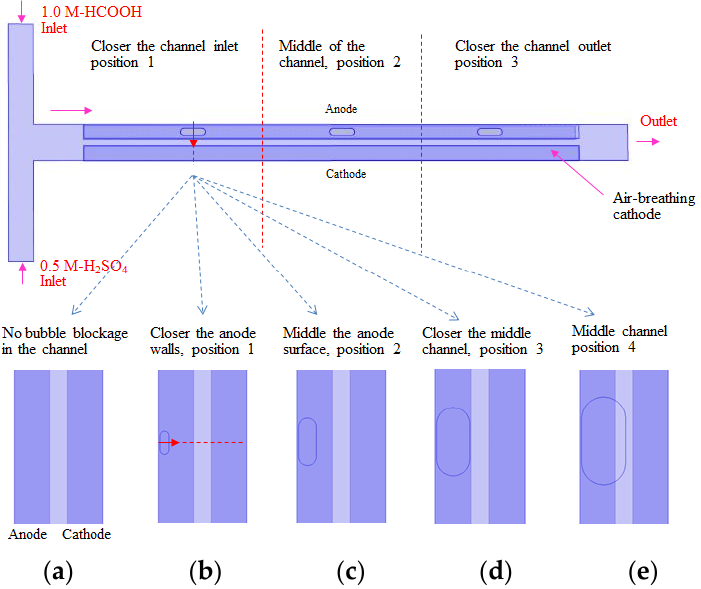
Figure 4. Distribution of bubble blockage starting from the anode walls to the middle of the channel at four specific positions of width coordinates of the channel: ( a ) no bubble; and bubble width of ( b ) 0.2 mm; ( c ) 0.4 mm; ( d ) 0.6 mm and; ( e ) 0.8 mm.